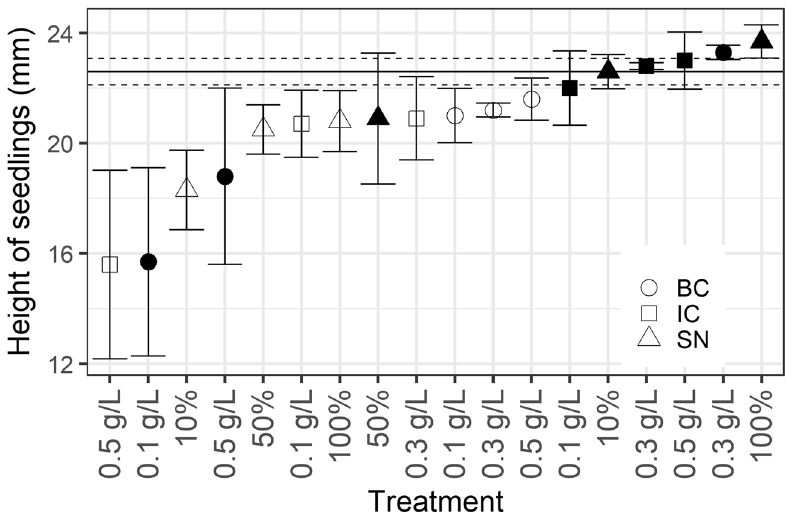
Figure 3. Height of tomato seedlings at day 14. Shapes indicate the mean of the ten measured seedlings from each treatment, filled shapes indicate C. vulgaris (13–1), open shapes indicate S. obliquus (B2–2). IC squares, BC circles, SN triangles. Mean of the control group is indicated by the horizontal line. Error bars indicate ± s.e.m. (control group ± s.e.m. is indicated by dashed horizontal